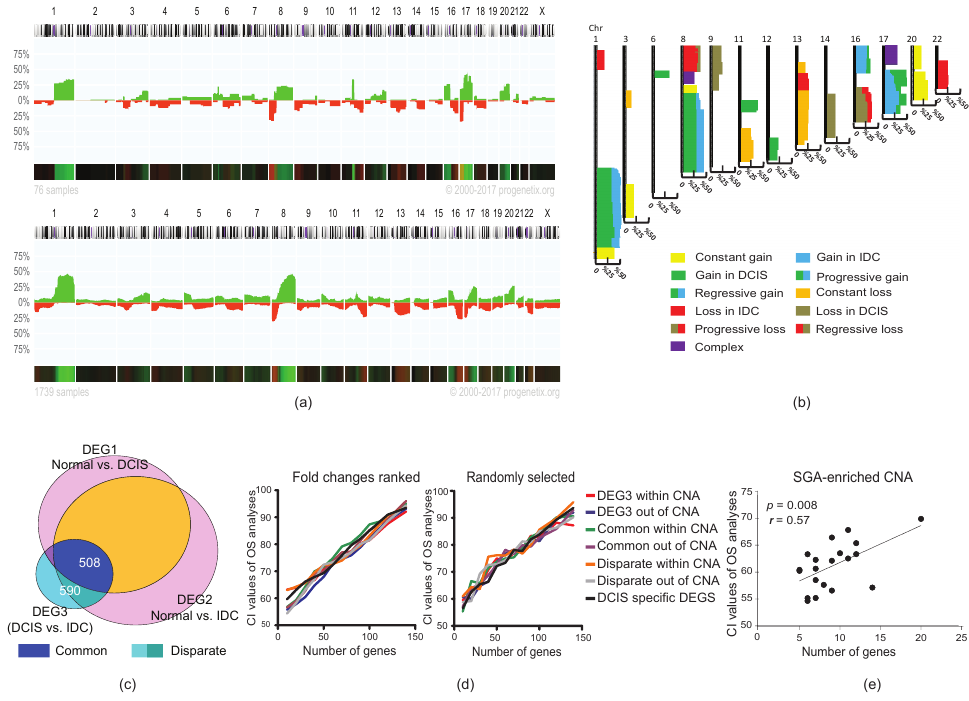
Figure 3. Integration of copy-number alteration (CNA) and single gene alteration (SGA) of DCIS and IDC. ( a ) CNA map of DCIS (up) and IDC (down) obtained from Progenetix database (DCIS = 76, IDC = 1739). The y-axis depicts the percentage of samples with aberrations (green stands for gain and red stands for loss) for each chromosomal region. ( b ) Map of CNA prototypes (see also Table S3). ( c ) A Venn diagram of common and disparate genes. ( d ) Correlation of concordance index (CI) obtained from overall survival (OS) analyses with the number of genes that selected based on ranked (left) or random (right) fold-changes to overall survival. Genes were selected from common, disparate, DCIS-specific, and DEG3 (IDC vs. DCIS) within and outside of CNAs. ( e ) Correlation of CI obtained from OS analyses with the number of genes in SGA-enriched CNA. The p -value in ( e ) was calculated by a Pearson correlation